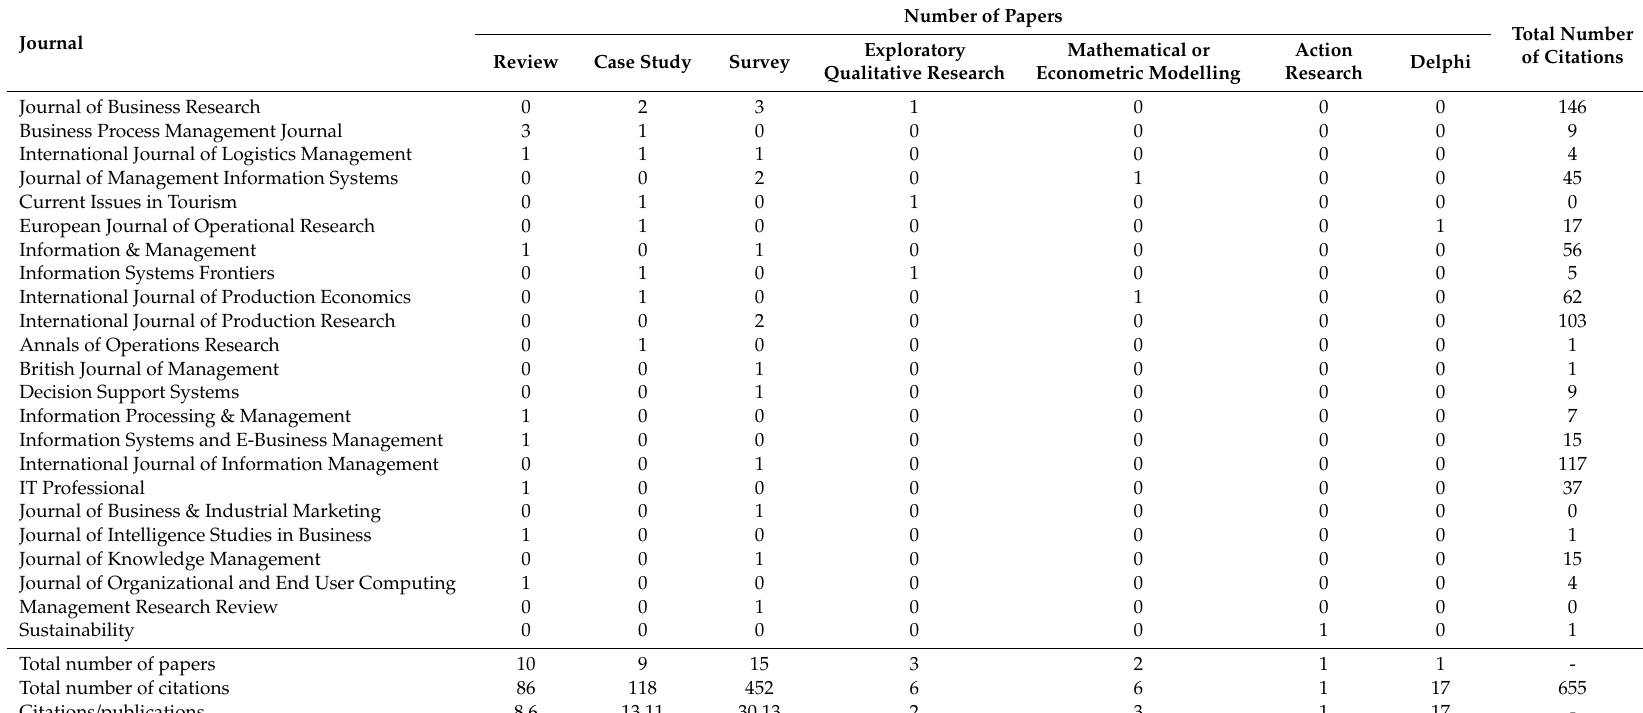
Table 3. Methods used in big data analytics and firm performance